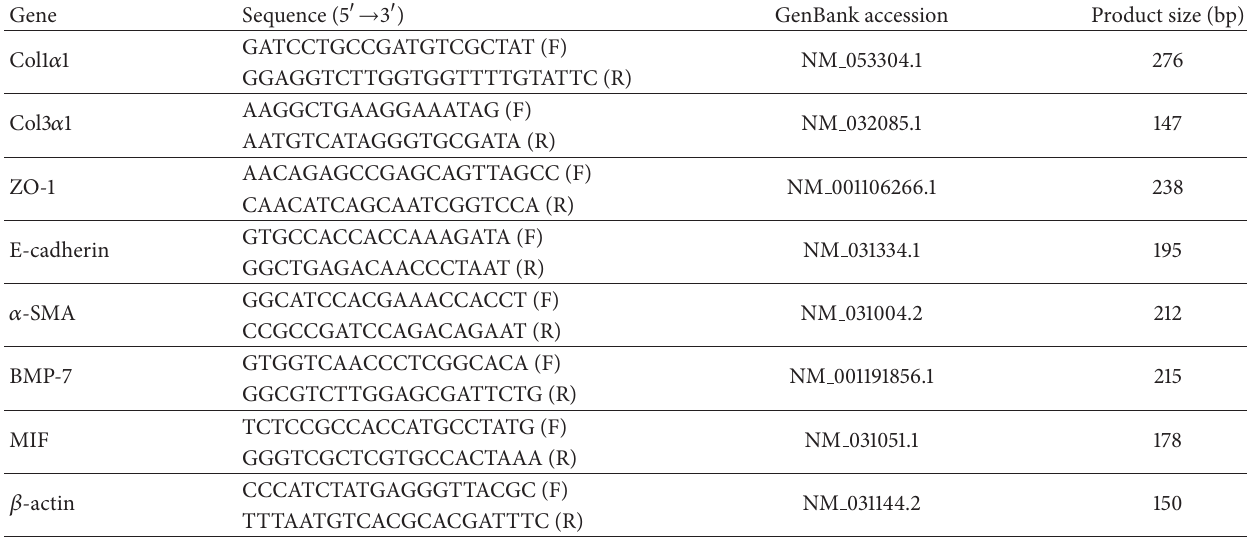
Table 1: qRT-PCR primers in this